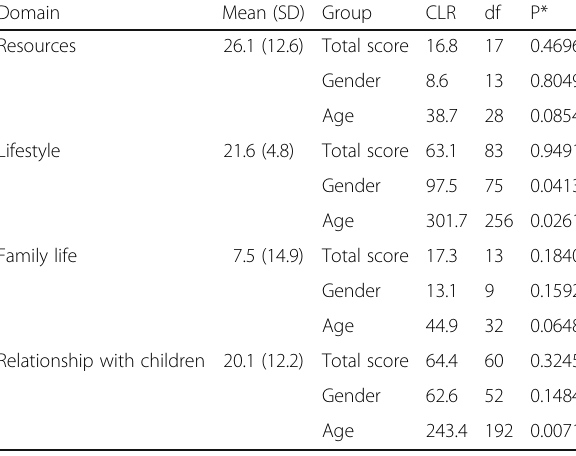
Table 1 Mean, SD, and over-all model fit evaluated by Andersen ’ s conditional likelihood ratio (CLR) for each